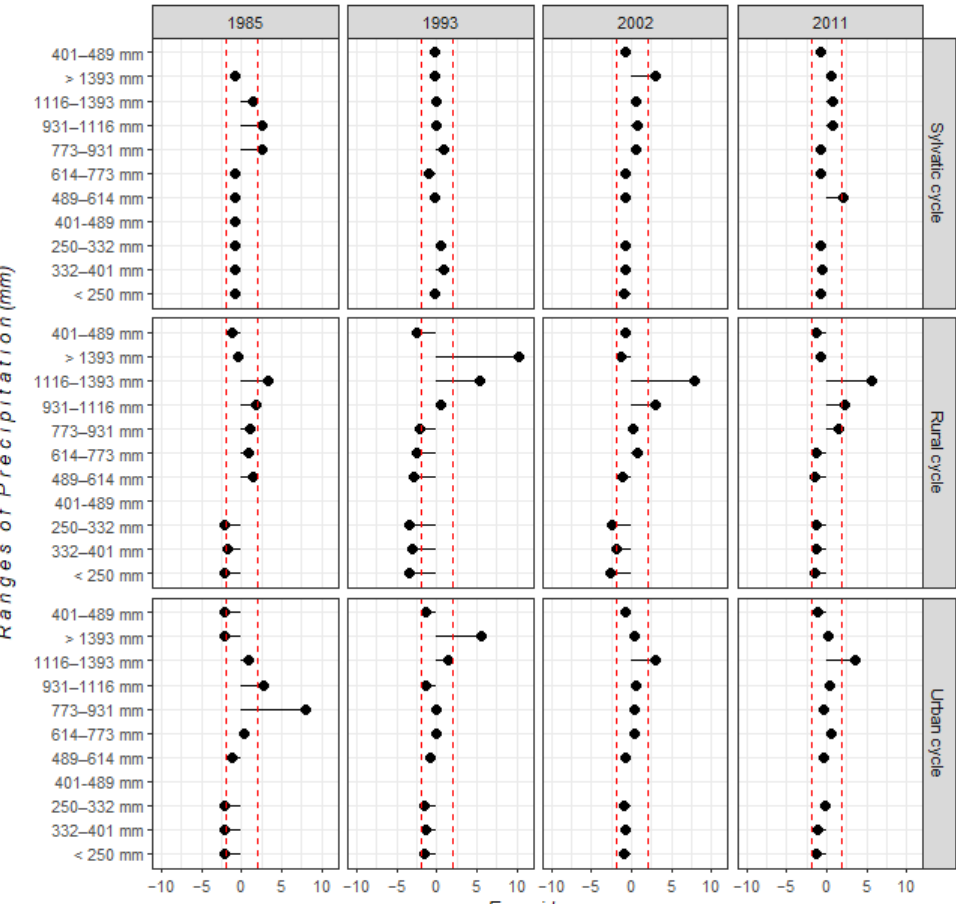
Figure 3. Statistical relationship between each precipitation range and each T. cruzi transmission cycle, based on ε -values. The red dotted line indicates confidence intervals of statistically significant correlations (i.e., | ε | > 1.96).